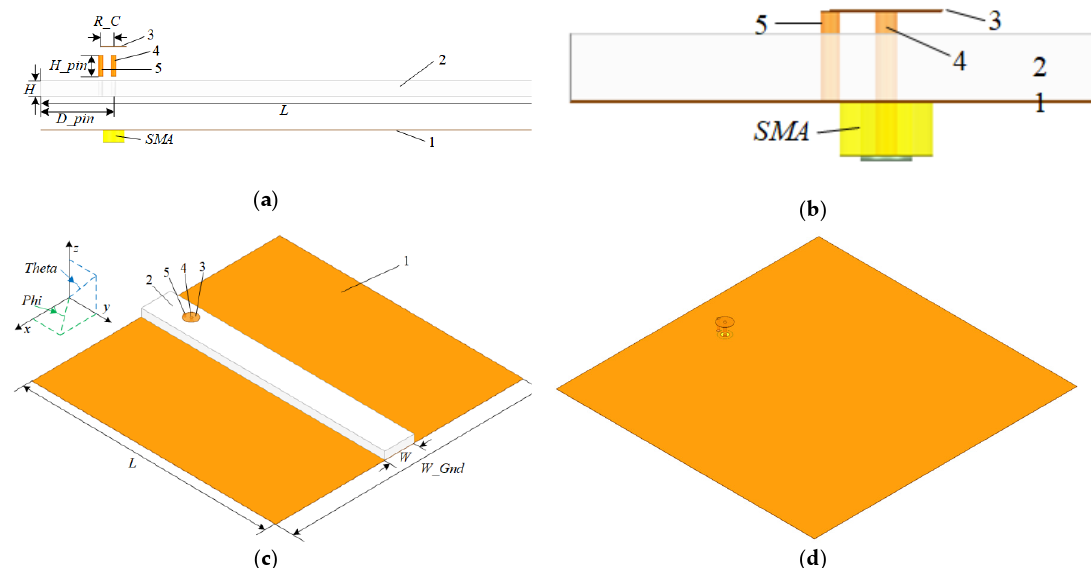
Figure 1. Configuration of the proposed conformal surface wave antenna: ( a ) side view of each split structure; ( b ) large view of feed; ( c ) perspective view; ( d ) perspective view without dielectric.